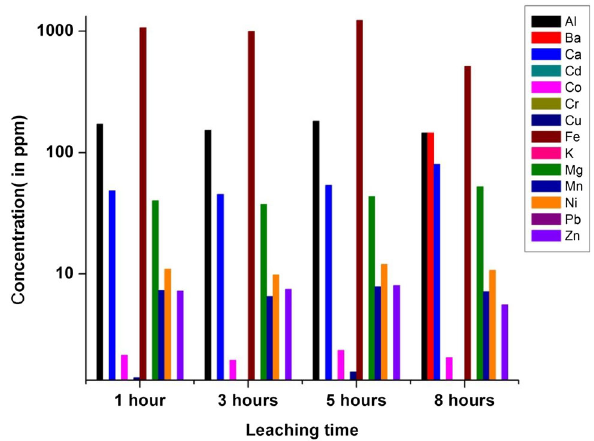
Fig. 26 Change in elemental concentration (in ppm) in aqueous leachates of Ledo coal (LC-60A) with leaching time (in hour) at 45 (cid:3)